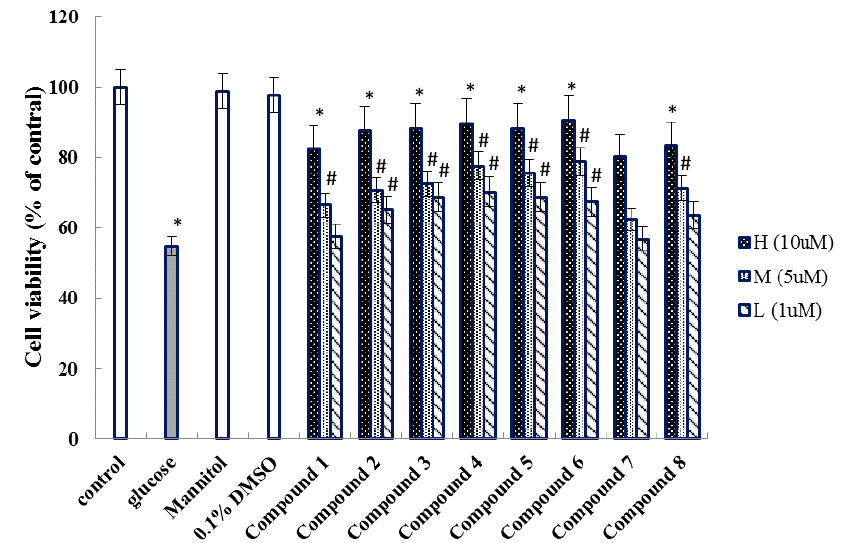
Figure 3. The protective effect of compounds 1 – 8 on high concentration glucose-induced viability of HUVECs. (mean ± SEM, n = 3); * p < 0.01 vs control; # p < 0.05 vs. Glucose. (Glucose: 30 mM; Mannitol: 30 mM).